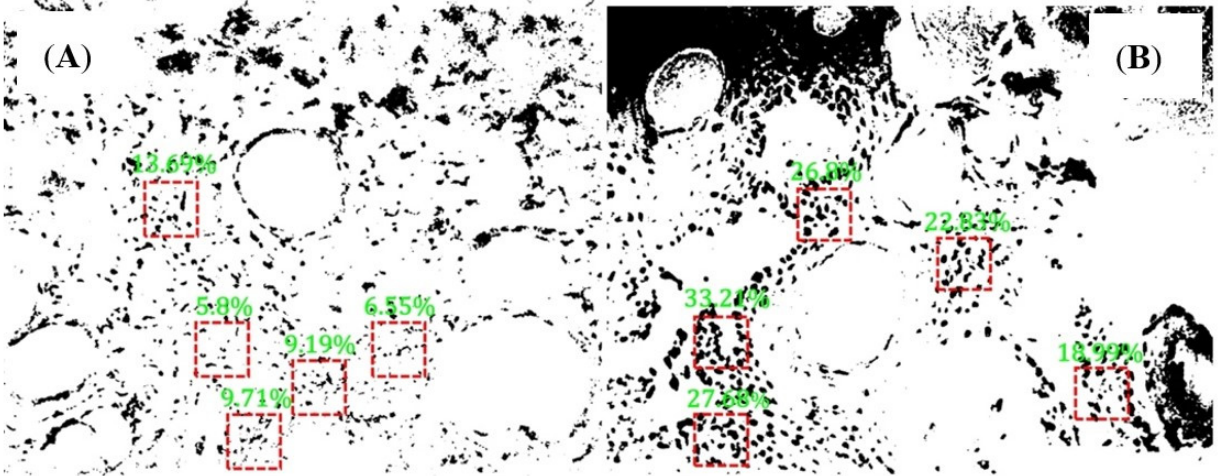
Figure 4. Comparison of the nucleoplasmic ratio between normal tissue sections and cSCC tissue sections. ( A ) the nucleoplasmic ratio of normal tissue; ( B ) the nucleoplasmic ratio of cSCC cancerous tissue.